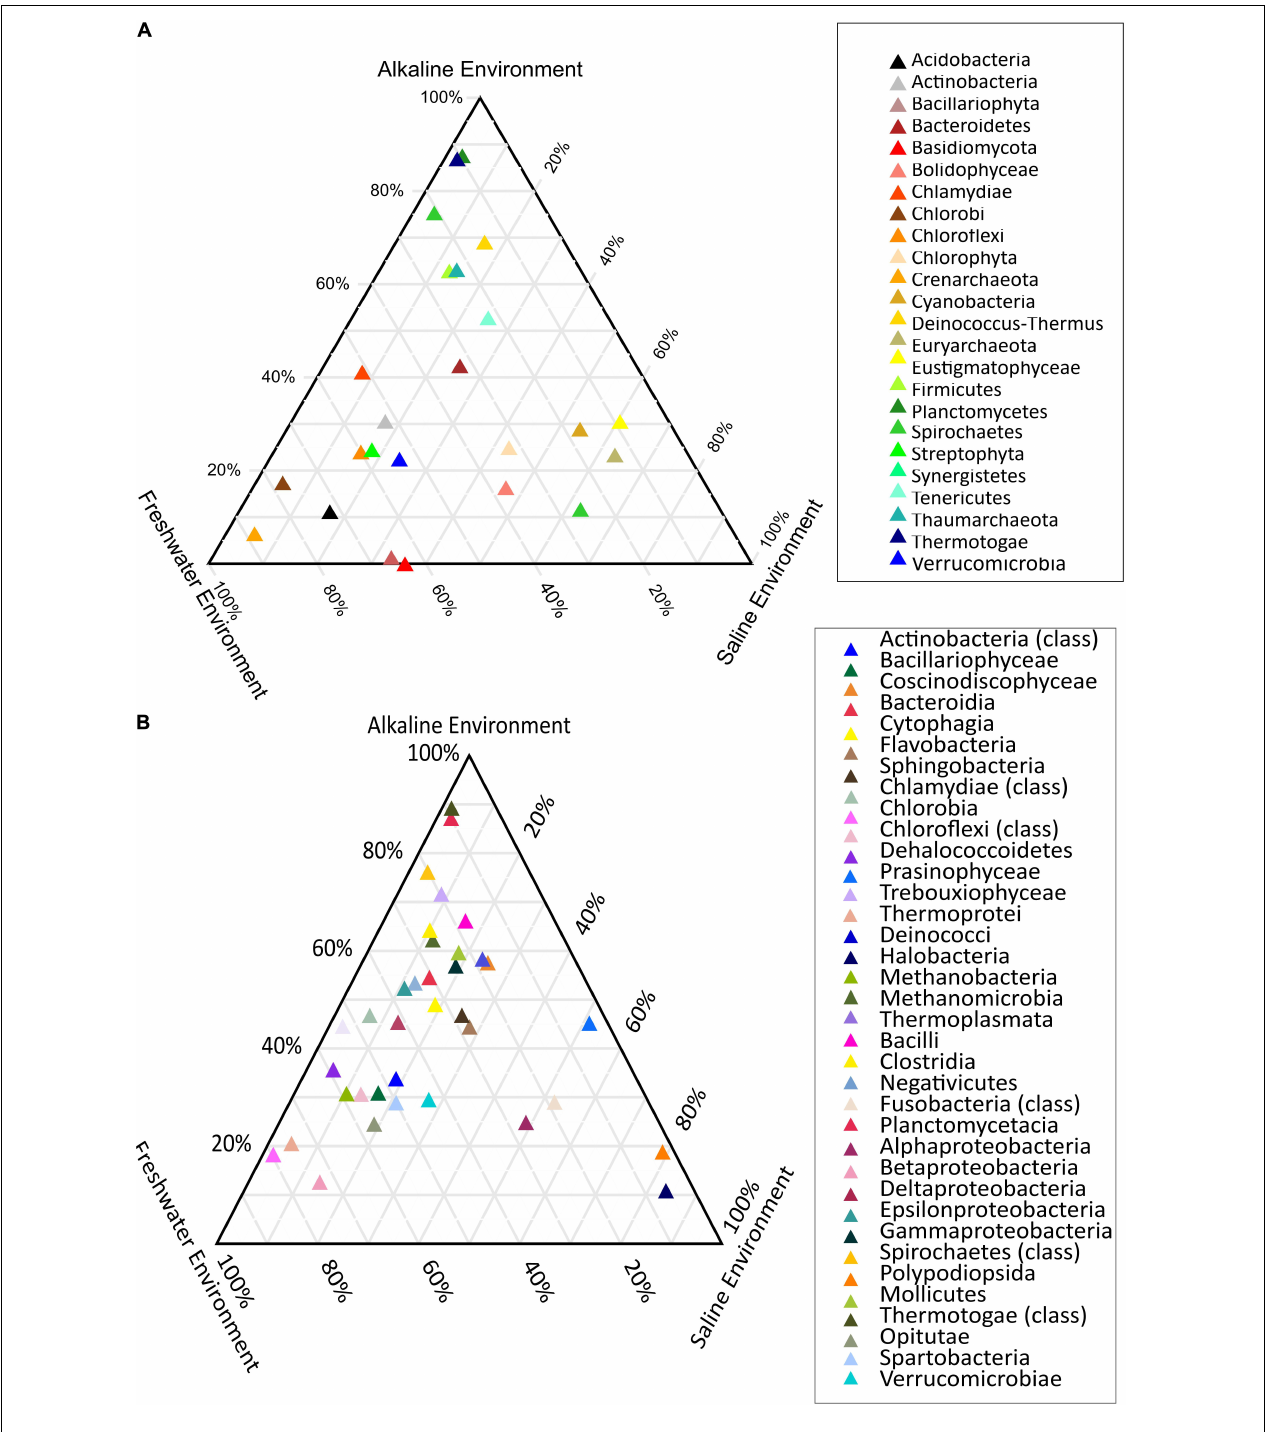
FIGURE 4 | Ternary plots showcasing the differential microbiome composition using rRNA features phylogenetically affiliated at phylum (A) and class level (B) of the taxonomic hierarchy.